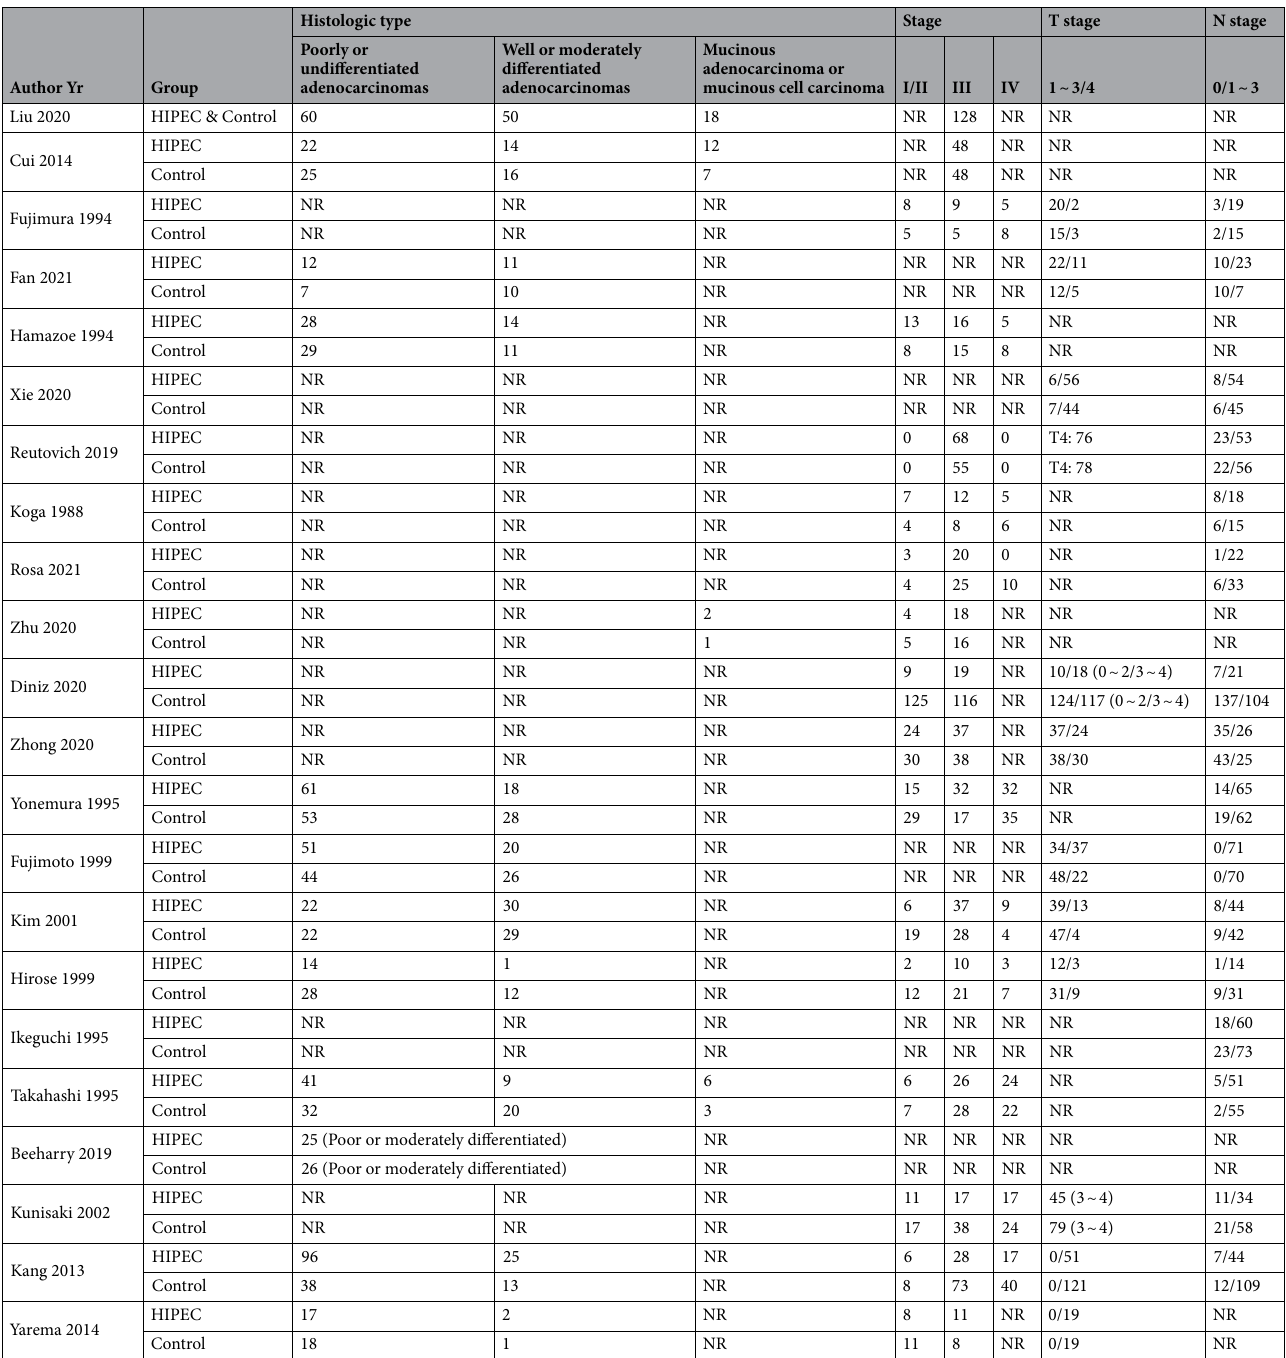
Table 3. Summary of the characteristics of patients in 22 eligible studies. HIPEC hyperthermic intraperitoneal chemotherapy, NR not recorded, Yr